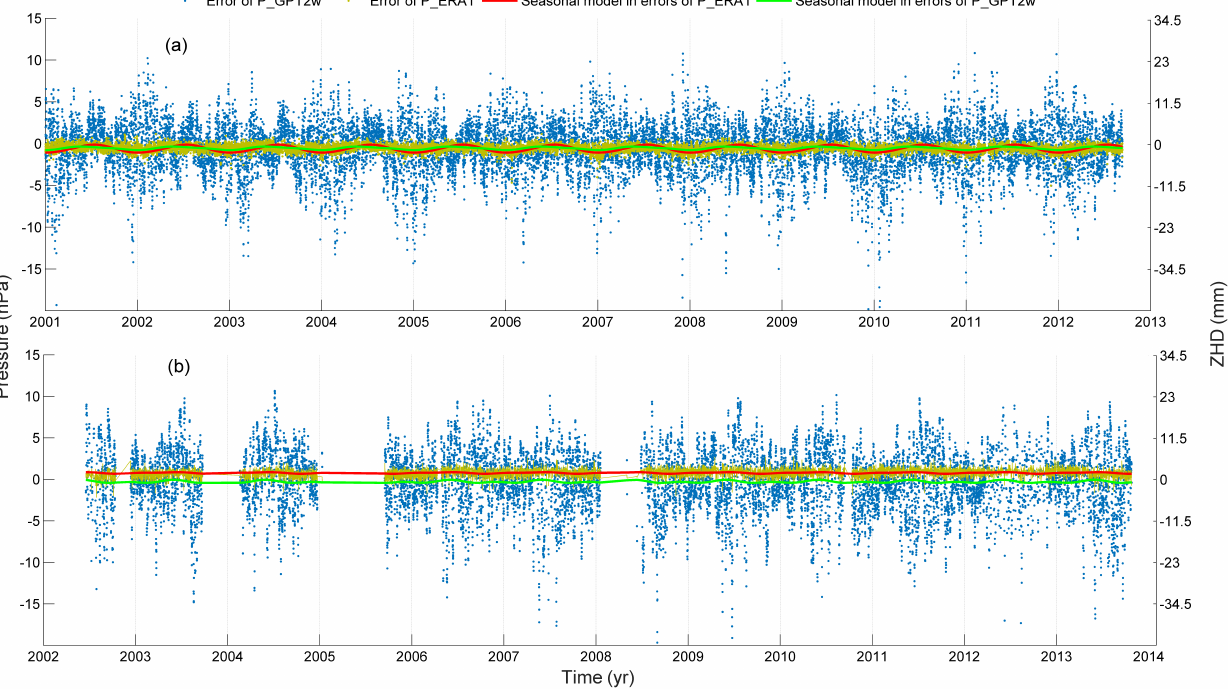
Figure 8. Time series of errors in pressure for stations JPLM ( a 34.2 ◦ N, 118.2 ◦ W) and SUTM ( b 32.8 ◦ S, 20.8 ◦ E) and the seasonal models estimated from the